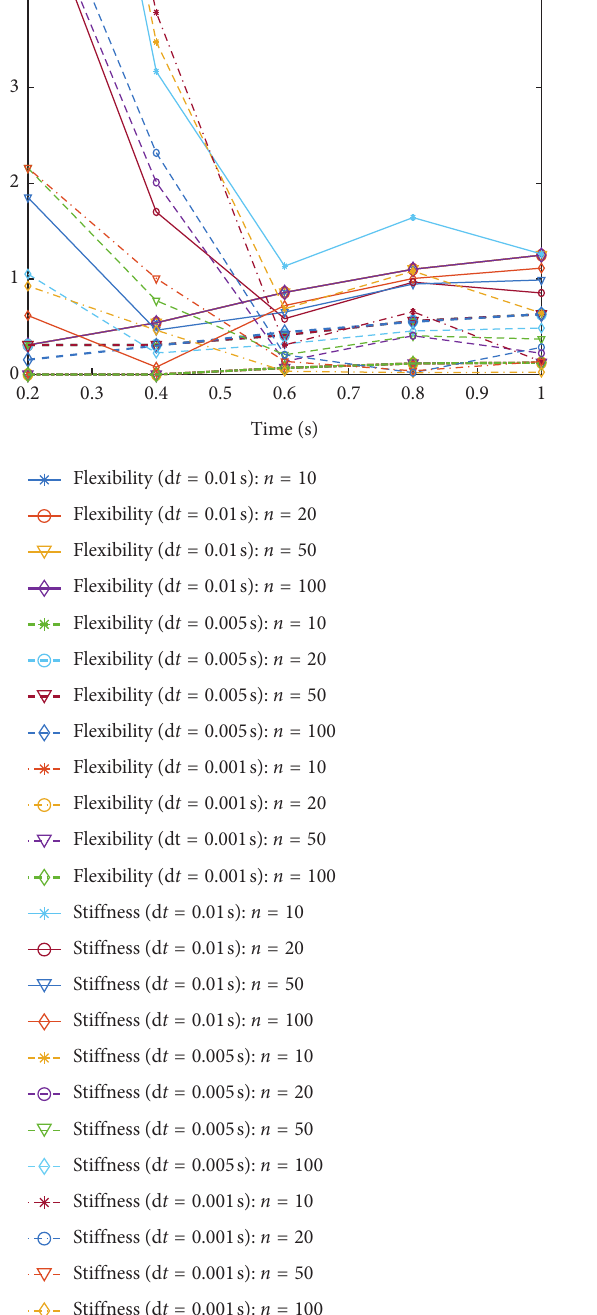
Figure 7: The relative error at 0.3 L . Figure 8: The relative error at 0.5 L